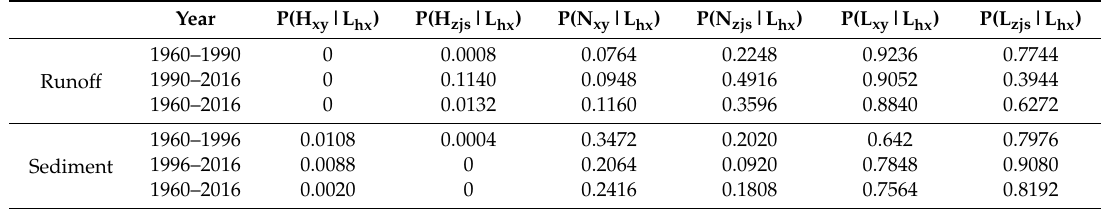
Table 5. Probabilities of low runoff (sediment) of the Huaxian Station caused, respectively, by high, normal, and low runoff (sediment) of Xianyang and Zhangjiashan